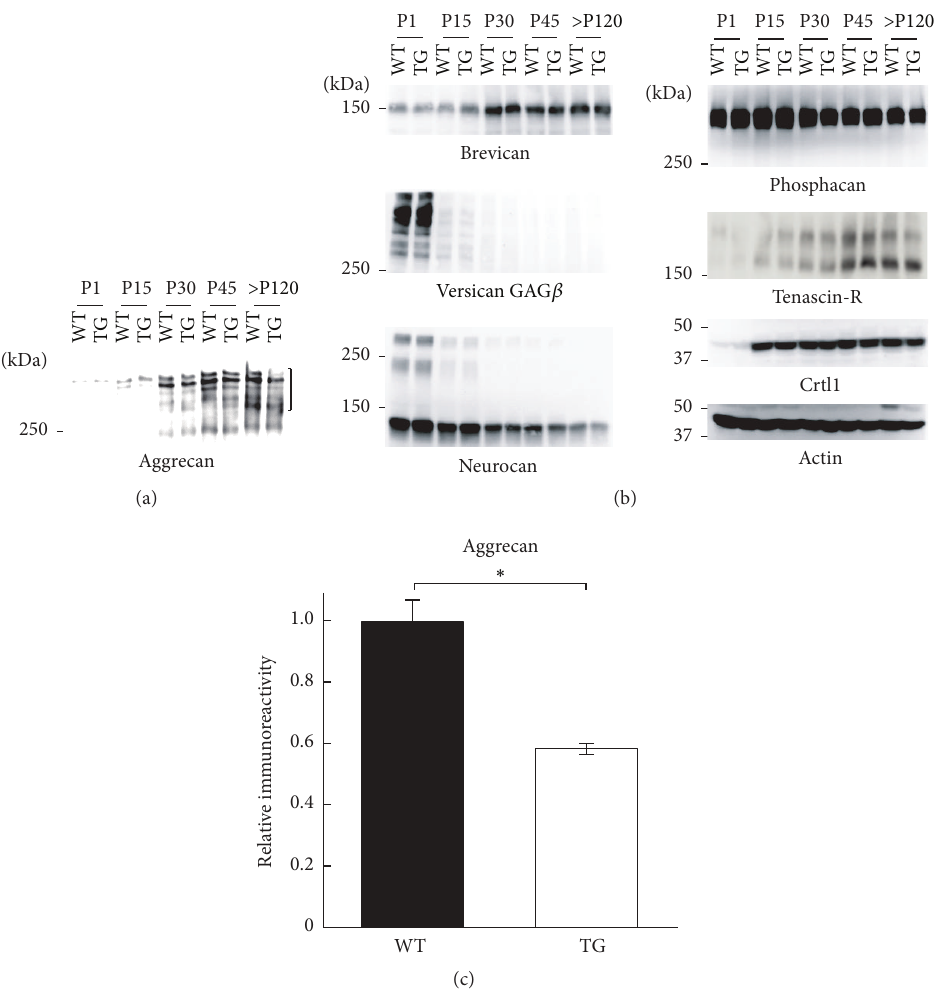
Figure 1: Developmental expression of PNN components in detergent-soluble fractions of WT and C6ST-1 TG mouse brain. (a) Expression of aggrecan in the brain of WT and C6ST-1 TG (TG) mice from postnatal day (P) 1 to > P120. (b) Expression of other PNN components, including brevican, versican GAG 𝛽 , neurocan, phosphacan, tenascin-R, and Crtl-1, during development. Actin was detected as loading control. (c) Densitometric quantification of aggrecan in the aged brain ( > P120). Intensity values were generated by measuring the signal intensity in the region indicated by the bracket. Asterisks denote significant differences ( 𝑃 < 0.05 , Student’s t -test) between WT and TG mice. Error bars represent SEM; 𝑛 = 3 for each